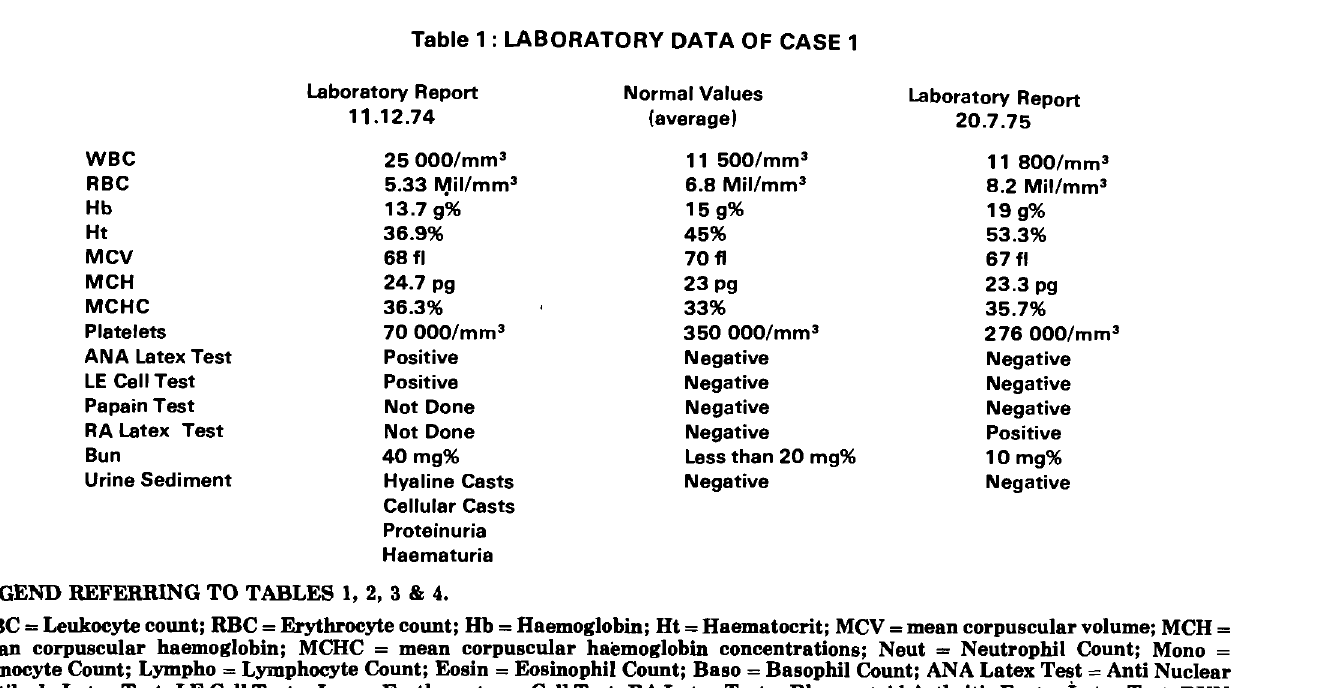
Table 1 : LABORATORY DATA OF CASE 1